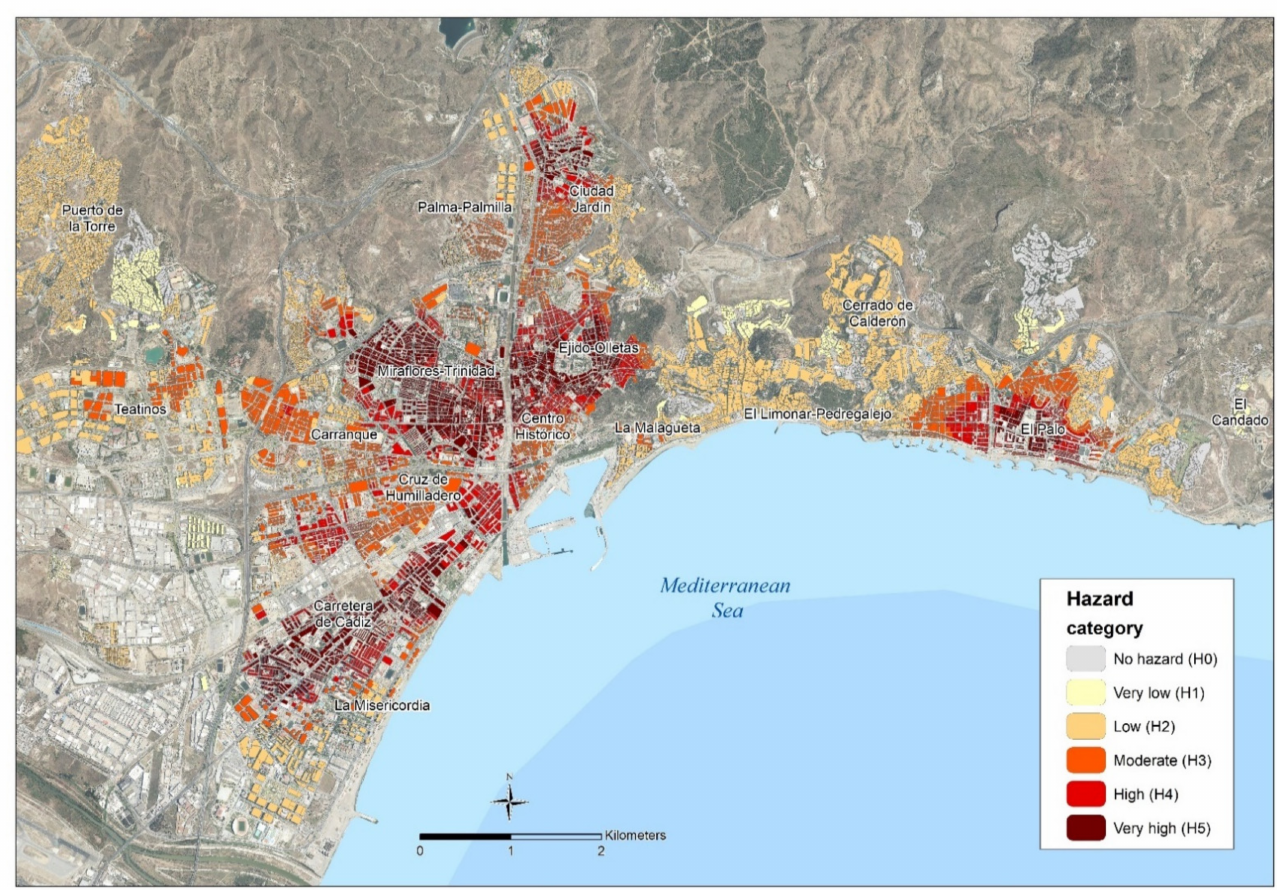
Figure 7. Hazard of contagion per building